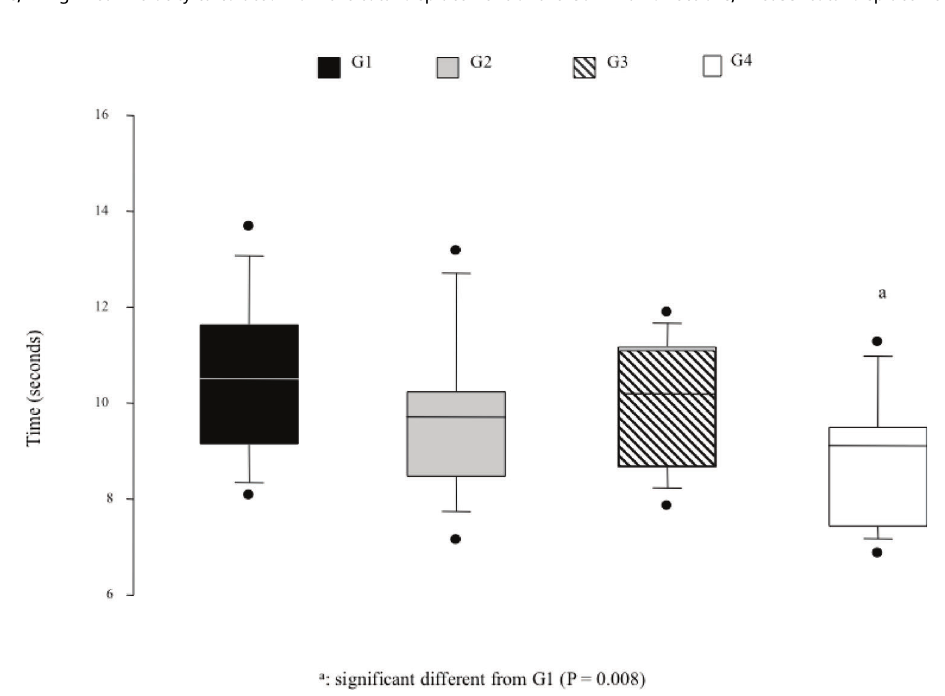
Figure 1 - Timed Up and Go Test (TUGT) (95%